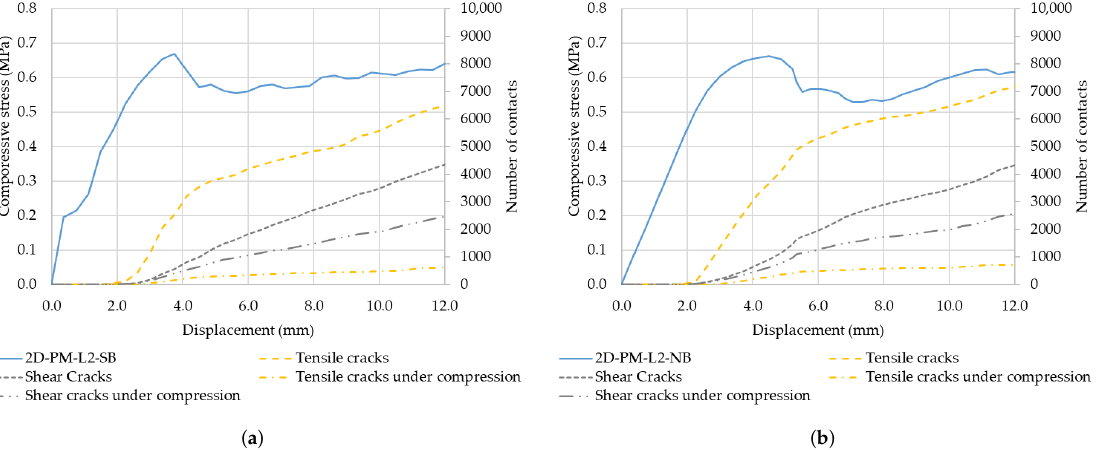
Figure 15. Stress–displacement diagram and crack evolution for 2D-PMR models with ( a ) strong bond approach and ( b ) without a